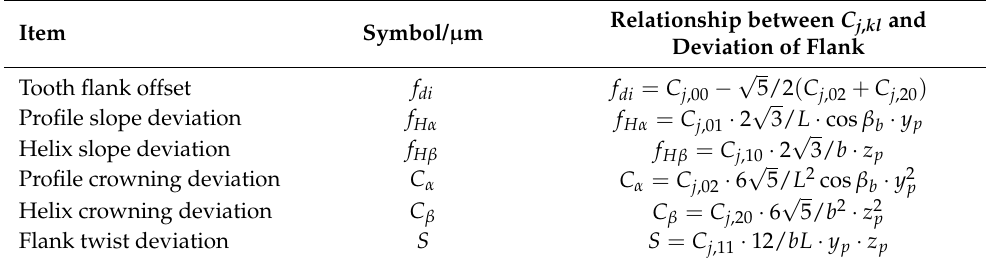
Table 2. Relationship between expansion coefficients and typical deviations of tooth flank. Item Symbol/ µ m